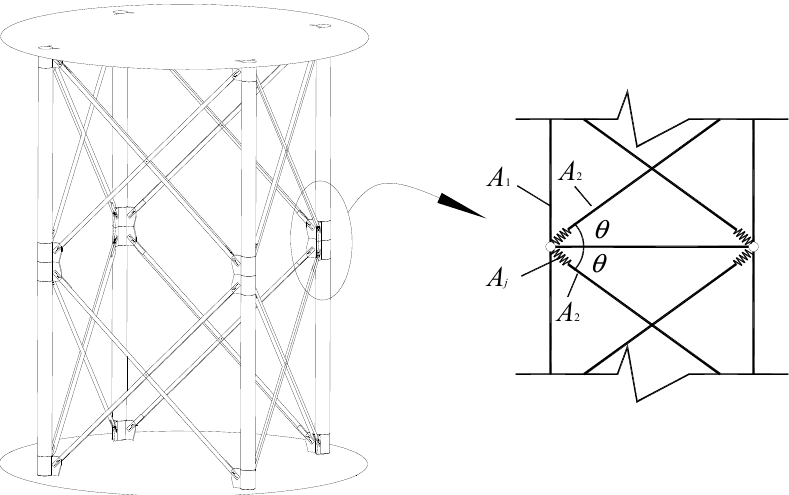
Figure 11. Simplified calculation model of axial stiffness of DLDPJ. The strain energy of DLDPJ is shown in Equation (16).